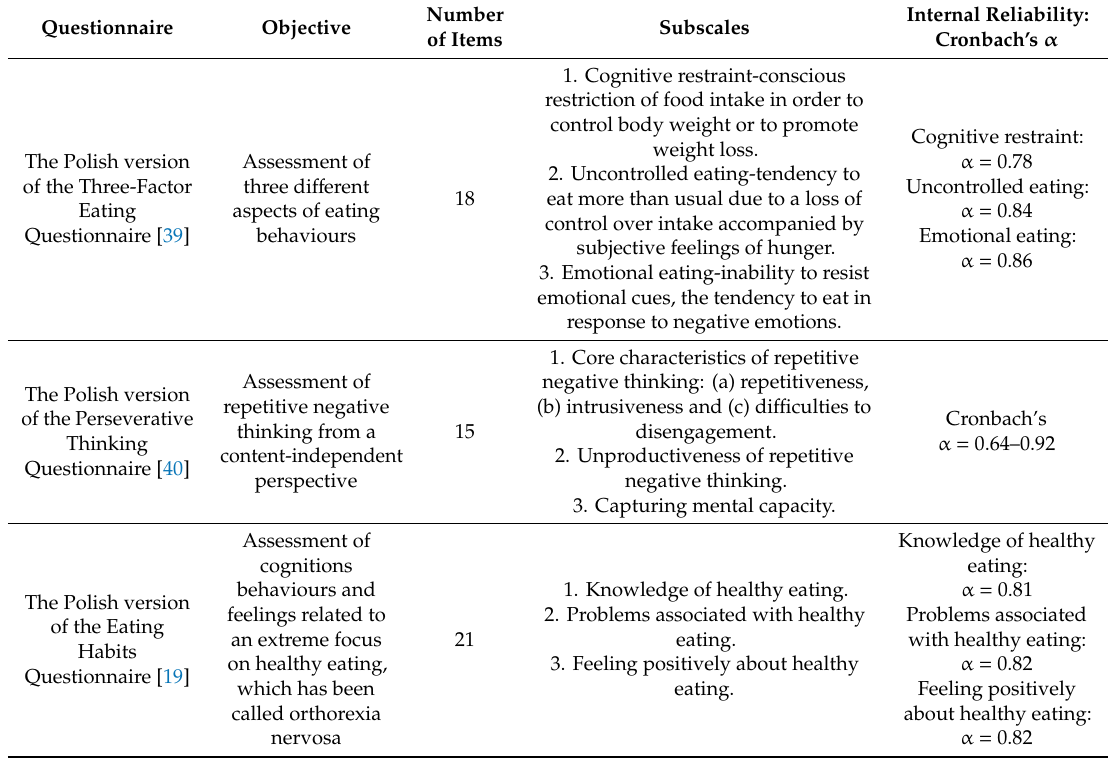
Table 2. Characteristics of measurements used in the present